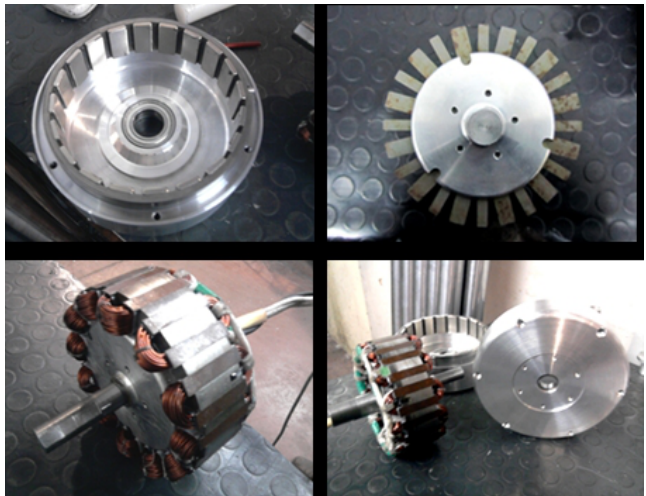
Figure 8. Manufacture of a 1 kW 24/20 slot–pole surface mounted permanent magnet (SMPM)